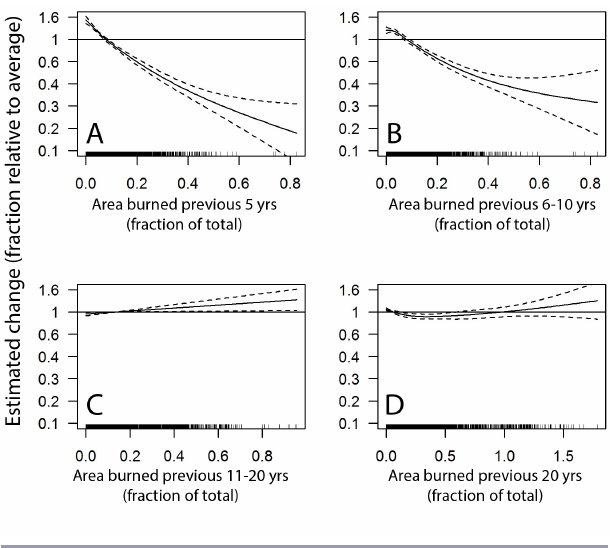
Fig. 6 . Change in average area burned in any given year as a function of area burned in the previous 5 years (A), 6 to 10 years (B), 11 to 20 years (C), and more than 20 years